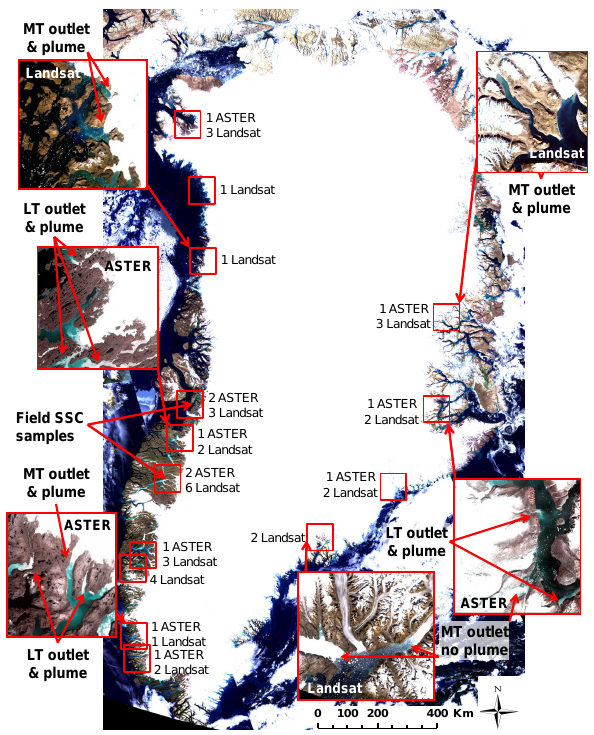
Fig. 2. MODIS mosaic of Greenland (RGB=bands 1, 4, 3) with Landsat TM/ETM+(RGB=bands 3, 2, 1) and ASTER (RGB=bands 2, 1, 1) image locations used for classification val- idation. Remote sensing analysis included all fjords directly drain- ing the ice sheet through land-terminating glaciers (and down- stream rivers) or from marine-terminating glaciers where plumes may form. Landsat and ASTER images show examples of dif- ferent outlets and resulting plumes, including: (1) fjords fed by land-terminating glaciers, with large sediment plumes forming af- ter transport through a river (LT outlet and plume) (2) fjords with marine-terminating glaciers (MT outlet and plume), few icebergs and a visible plume, and (3) fjords with marine-terminating glaciers heavily calving ice and no visible plume (MT outlet no